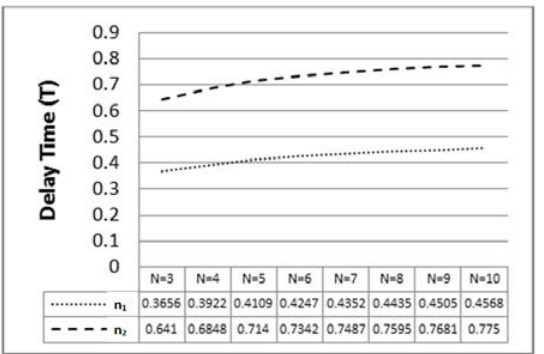
Figure 10: The packet delay time with a single sensor node Figure 11 is the delay time when a packet transferred through three and ten sensor nodes. The higher value of N is, the longer time of packet is delayed. The delay time gap would be higher if the transfer frequency is increased.